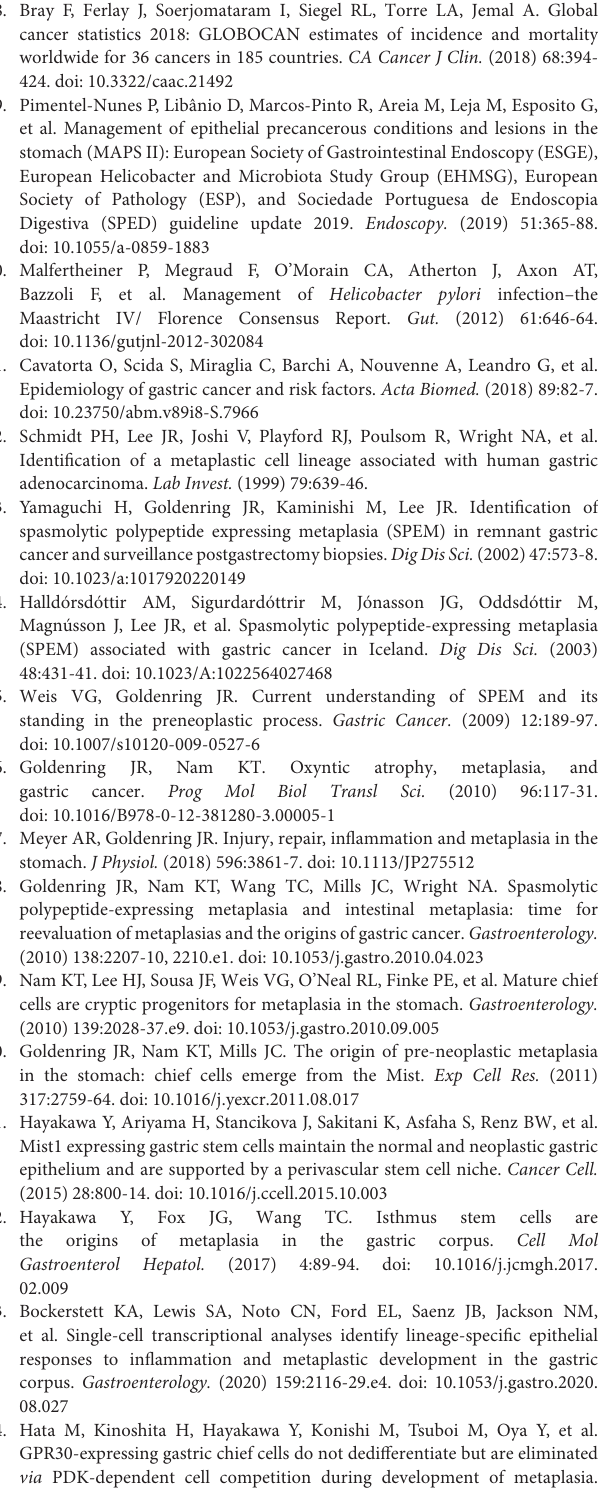
Supplementary Figure 2 | The timeline view of keywords in atrophic gastritis (AG) research.